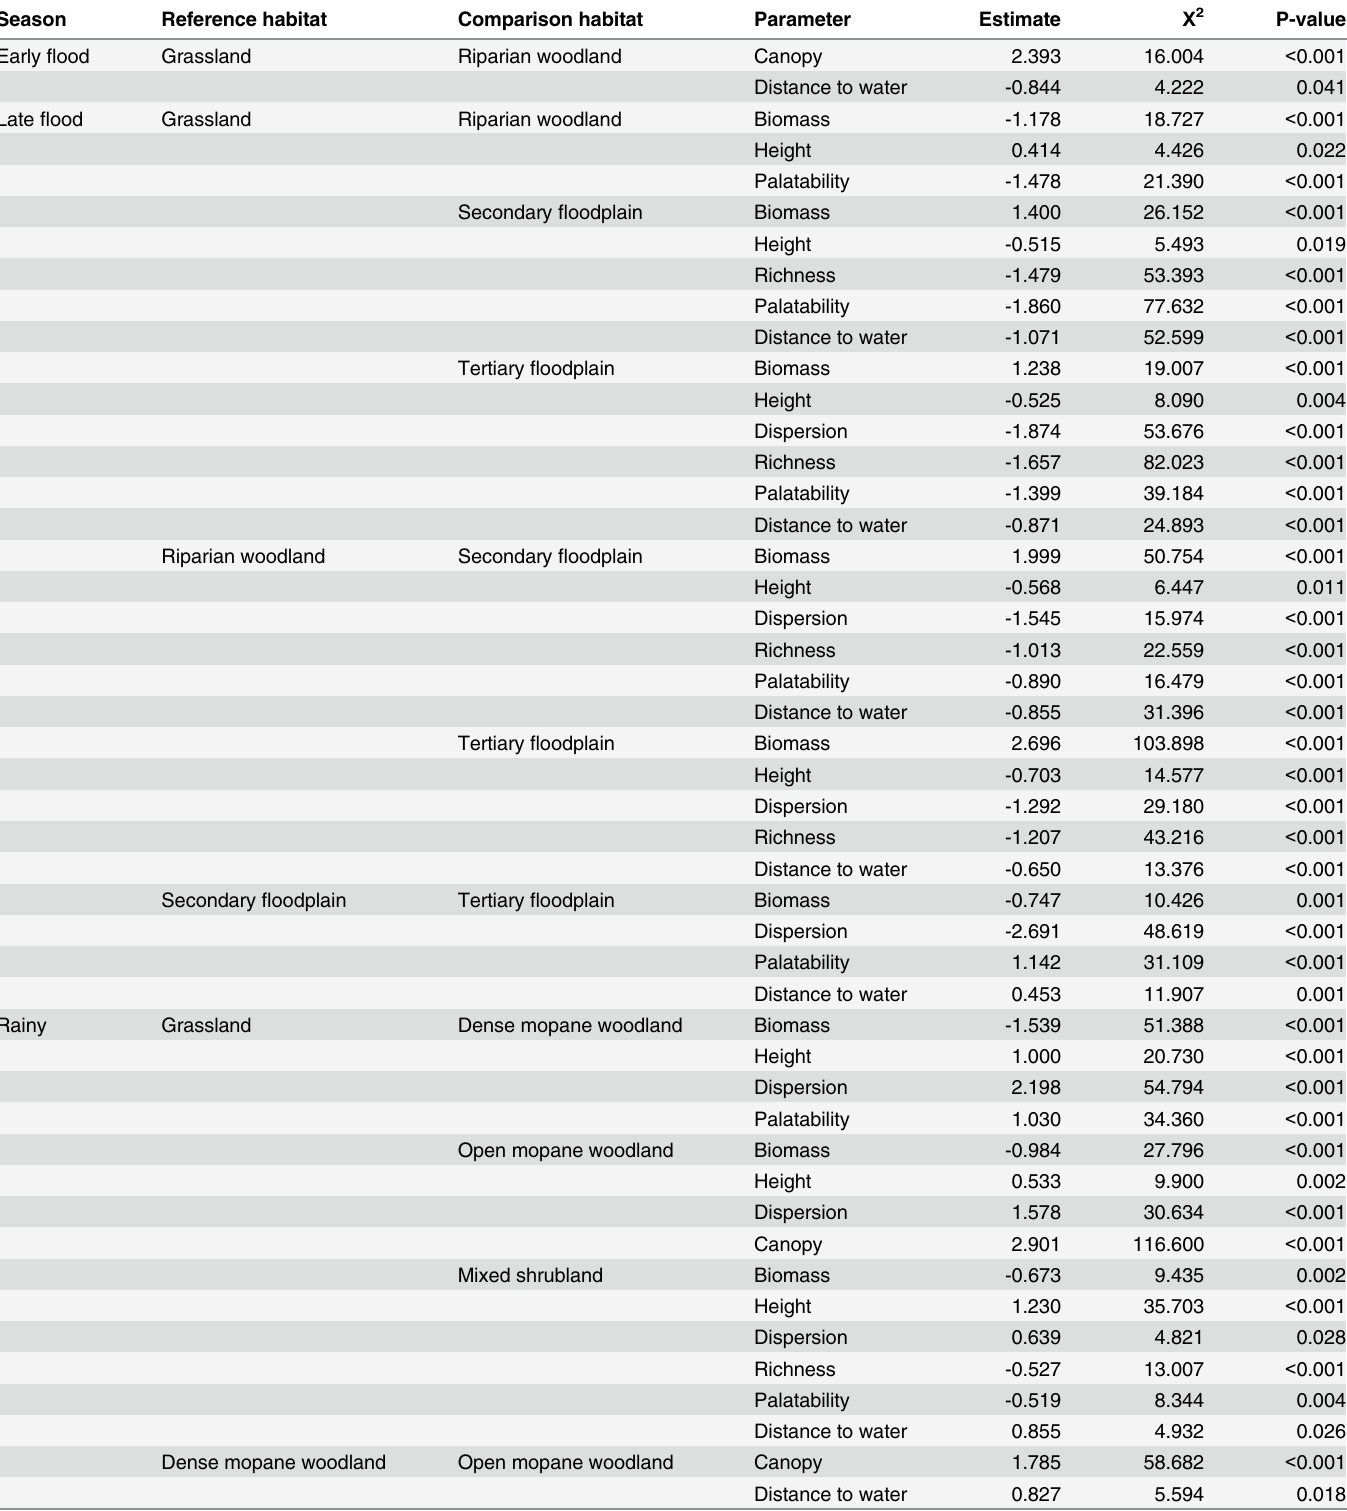
Table 5. Vegetation characteristics differing significantly between seasonally-preferred